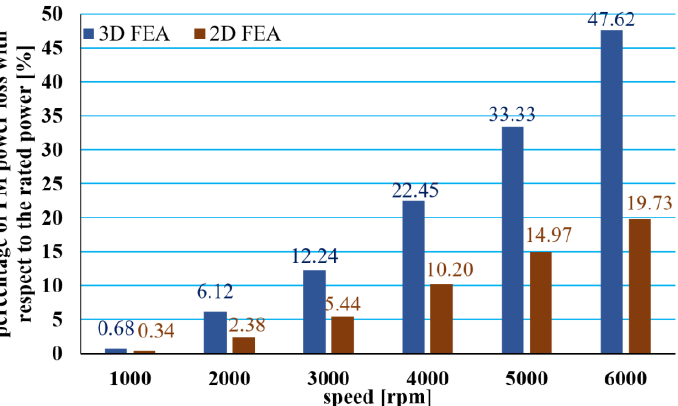
Figure 8. Non-segmented PM power loss in different operating speeds and comparison of the accuracy of the 2D and 3D FEA results for a 14.7 kW 4000 rpm 16 pole machine. The data to plot this figure was collected from [130].